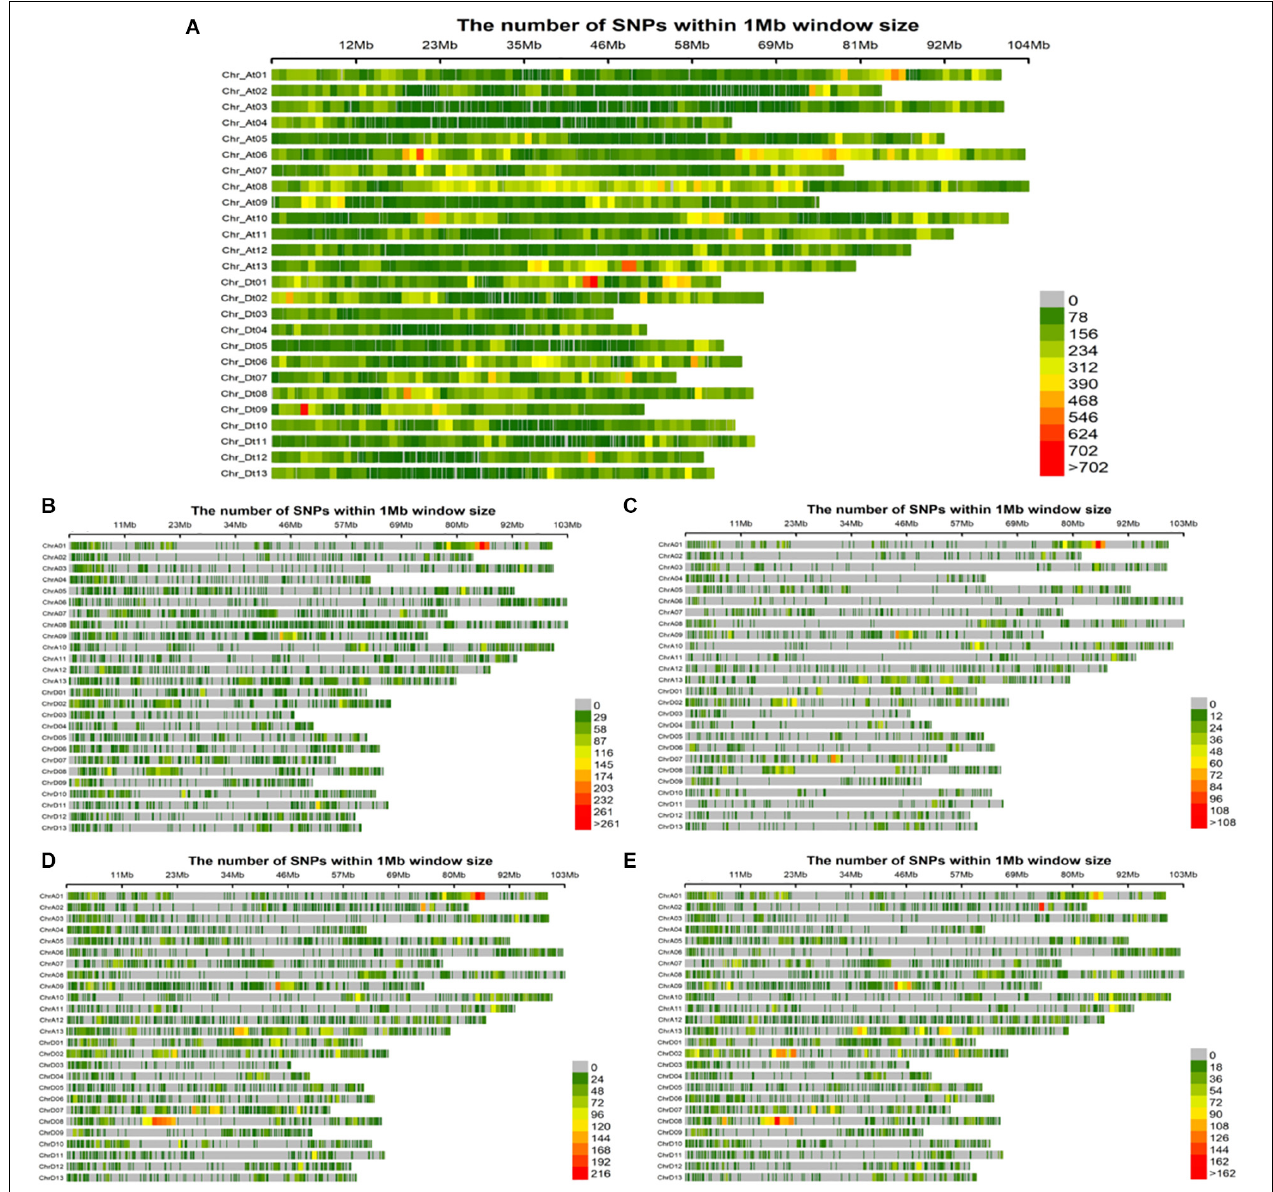
FIGURE 4 | Single nucleotide polymorphism (SNP) distributions on 26 chromosomes of (A) parents, (B) F 1 _A, (C) F 1 _C, (D) F 1 _D, and (E) F 1 _E. A t 1 ∼ A t 13 and D t 1 ∼ D t 13 in vertical axis are the serial number of 26 chromosomes; the horizontal axis shows chromosome length (Mb); = 0 ∼ > 702 depicts SNP density (the number of SNPs per window).